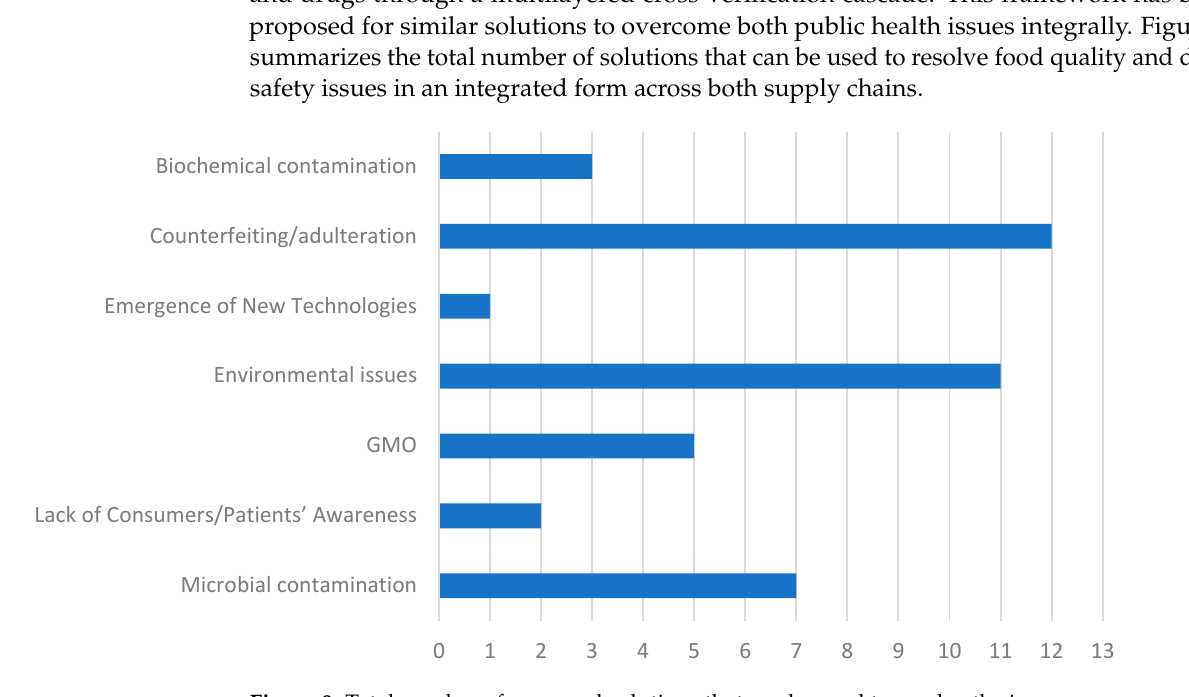
Figure 9. T otal number of proposed solutions that can be used to resolve the issues. Figure 9. Total number of proposed solutions that can be used to resolve the